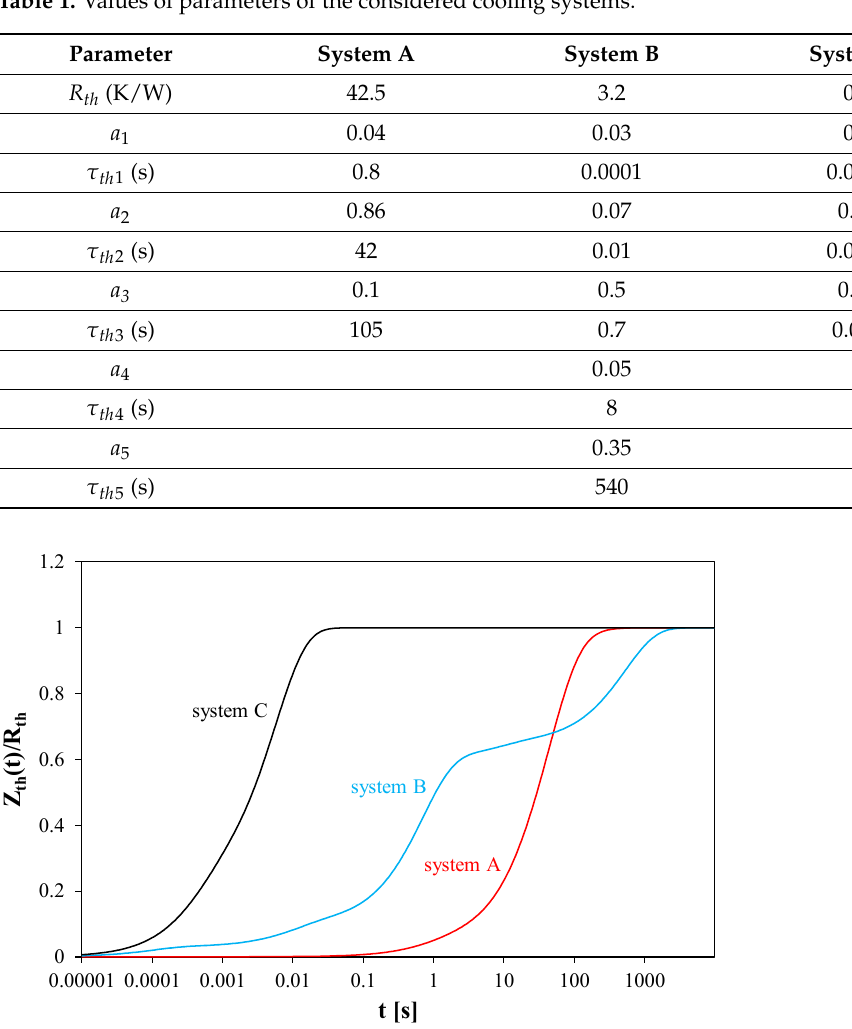
Table 1. Values of parameters of the considered cooling systems.